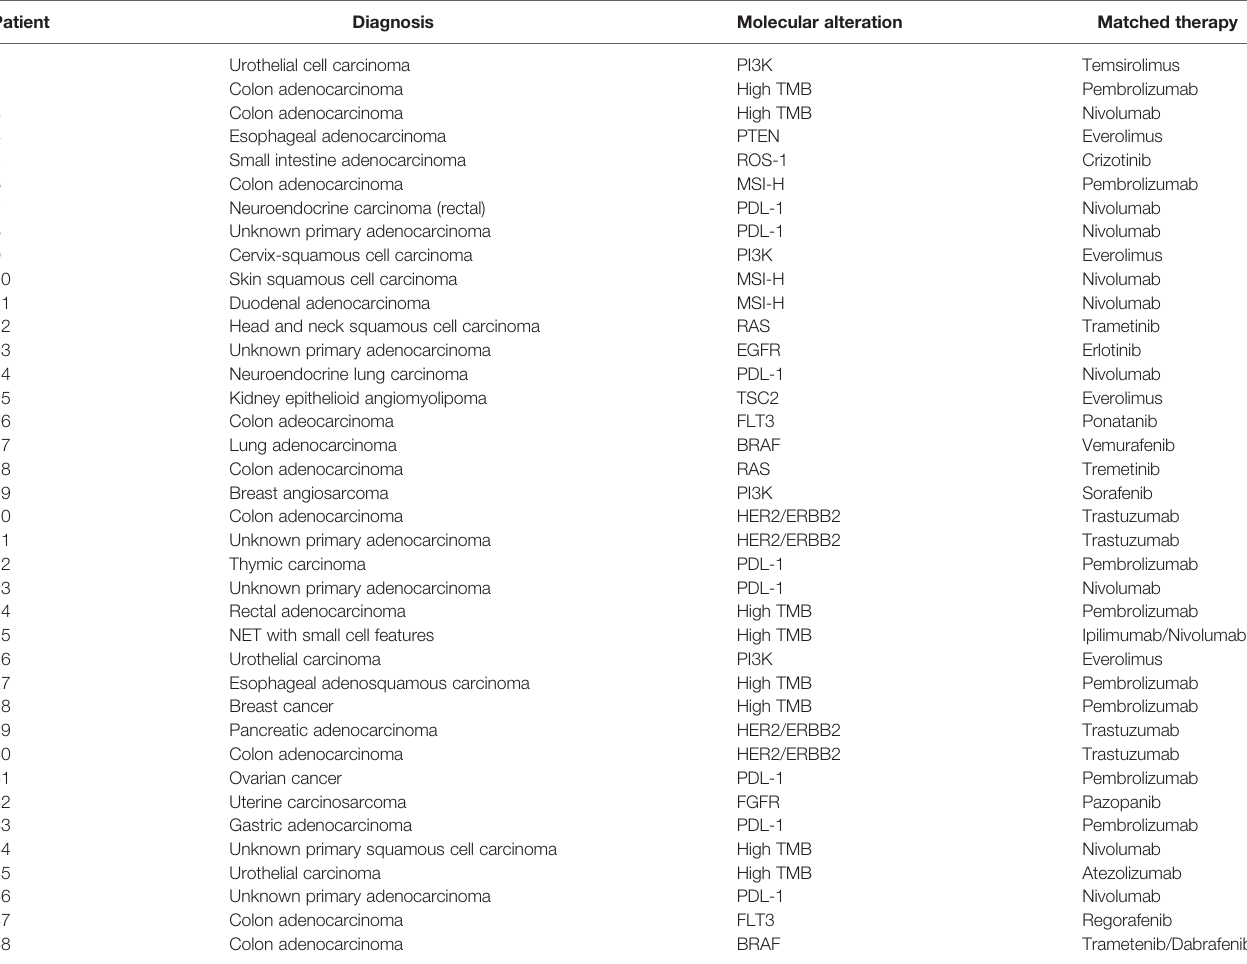
TABLE 3 | Molecular alteration and matched therapy.